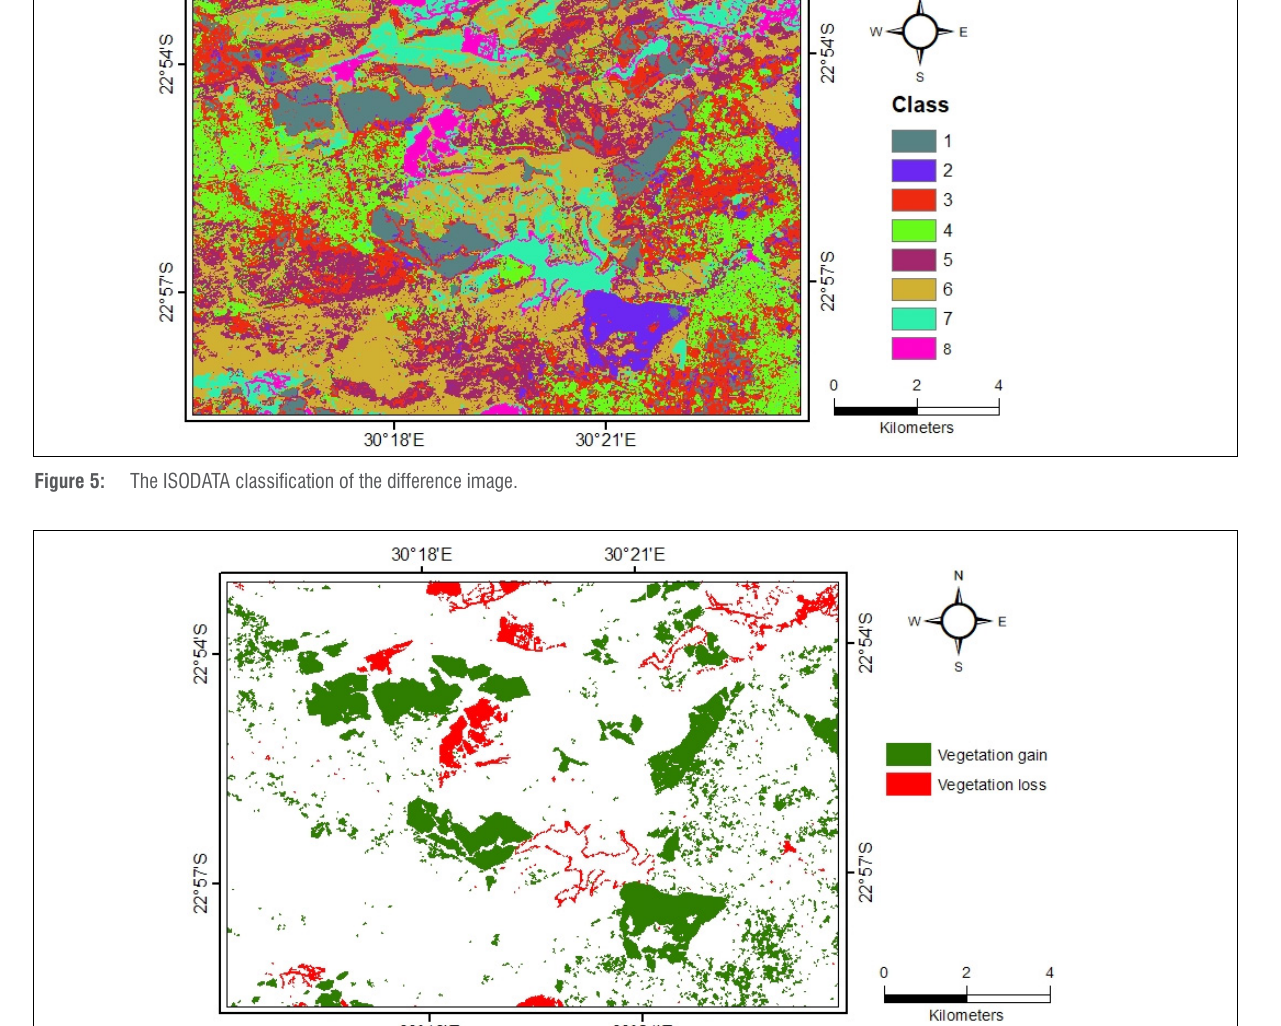
Figure 6: Vegetation gain vs vegetation